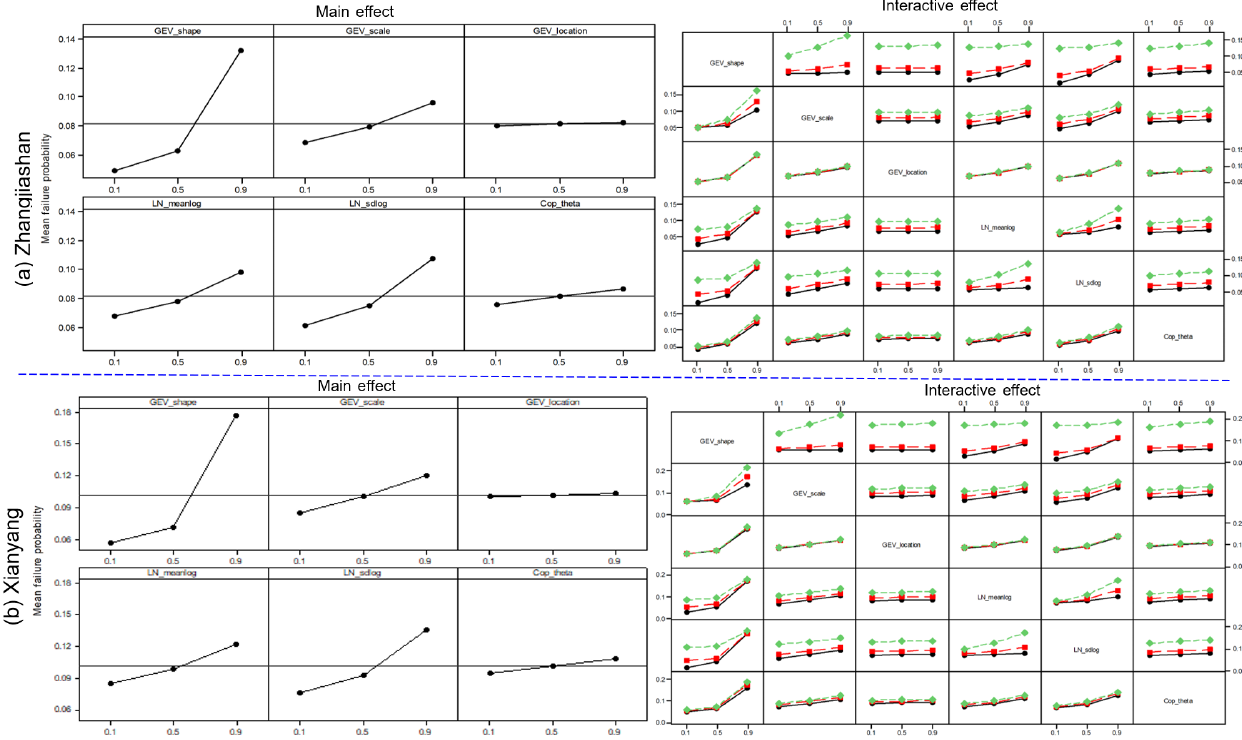
Figure 9. Main effects plot and full interactions plot matrix for parameters on the failure probability in Kendall at the two gauge stations.